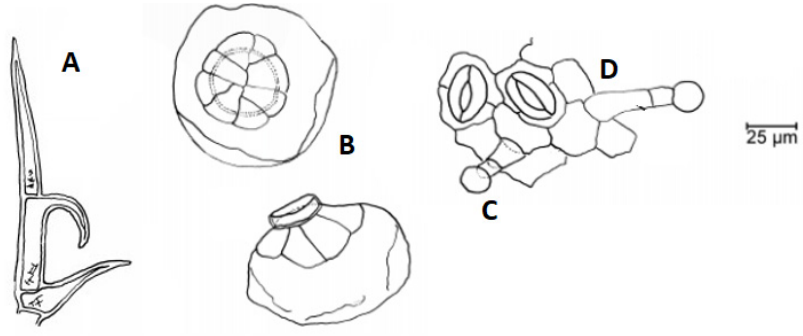
Figure 1. ( A ) Non-glandular trichome; ( B ) peltate octocellular glandular trichome, with a large secretory cavity; ( C ) stomata; ( D ) capitate glandular trichome.